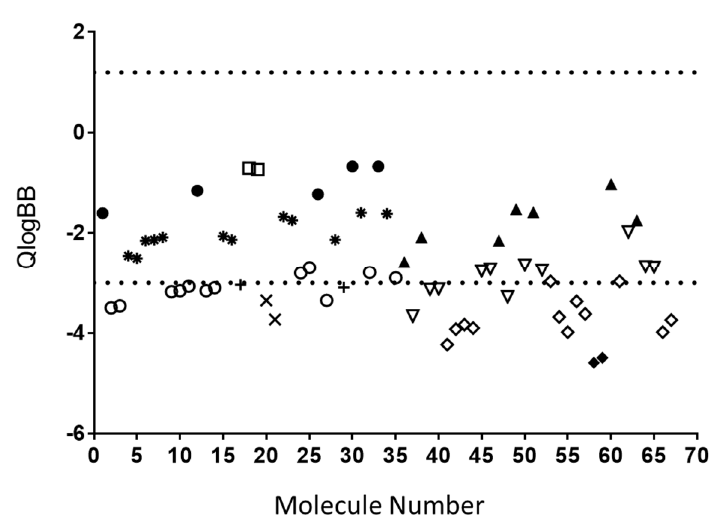
Figure 3. Predicted brain/blood partition coefficient (QPlogBB). QikProp predictions consider central nervous system positive molecule when QPlogBB coefficient is between –3 and 1.2 (range indicated with dashed line) for 95% of all known drugs to cross the BBB. Black circles: unconjugated PVLs; asterisk: PVL-sulfate conjugates (including methoxy-sulfate ones); white circles: PVL-glucuronide conjugates (including methoxy-glucuronide ones); cross: PVL-sulfate-glucuronide conjugates; oblique cross: PVL-disulfate conjugates; white squares: PVL-methoxy conjugates (not presenting sulfate or glucuronide moieties); black triangles: unconjugated PVAs; white triangles: PVA-sulfate conjugates (including methoxy-sulfate ones); white rhombus: PVA-glucuronide conjugates (including methoxy-glucuronide ones); black rhombus: PVA-sulfate-glucuronide conjugates.